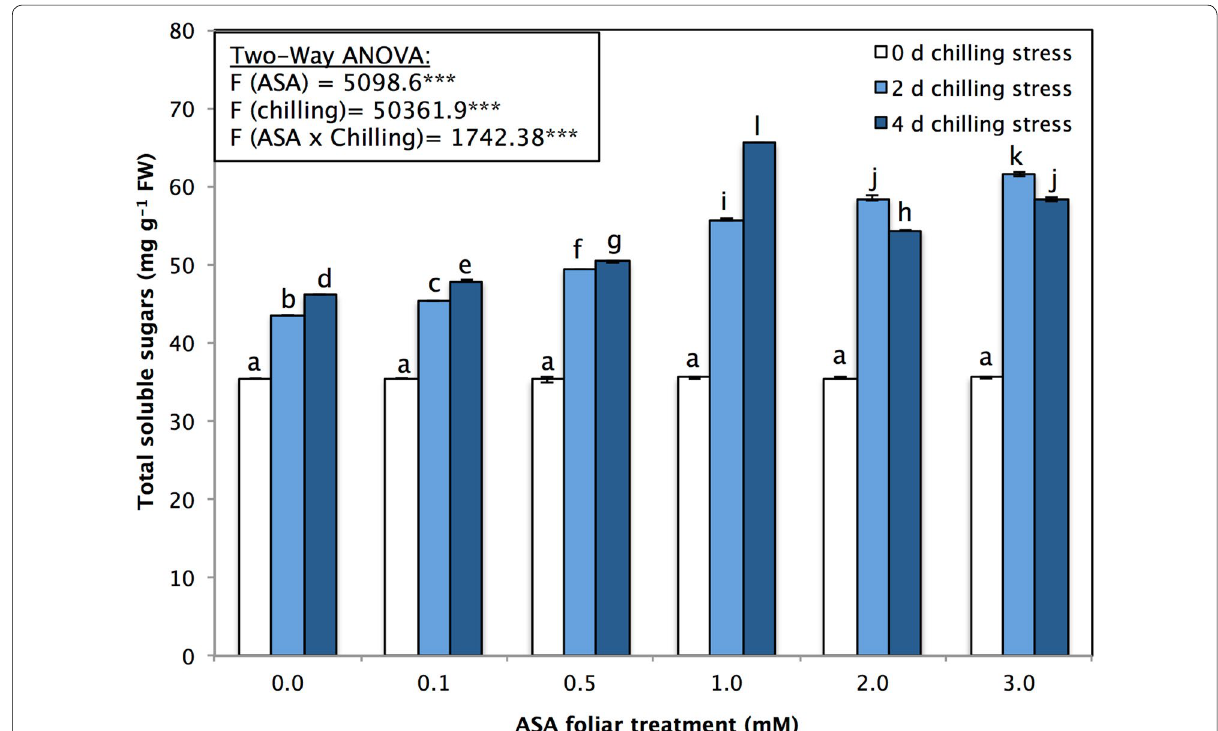
Fig. 1 Total soluble sugars (mg g − 1 FW) of P. vulgaris L. after foliar application of different concentration of acetylsalicylic acid (ASA; 0, 0.1, 0.5, 1, 2, 3 mM) and exposed to different level of chilling stress (0, 2, 4 days). Data represented are mean of two replicates between different chilling stresses and foliar ASA concentration were assessed by univariate analyses followed by post hoc analysis. Means with the same letters are not significantly different according to Duncan’s multiple